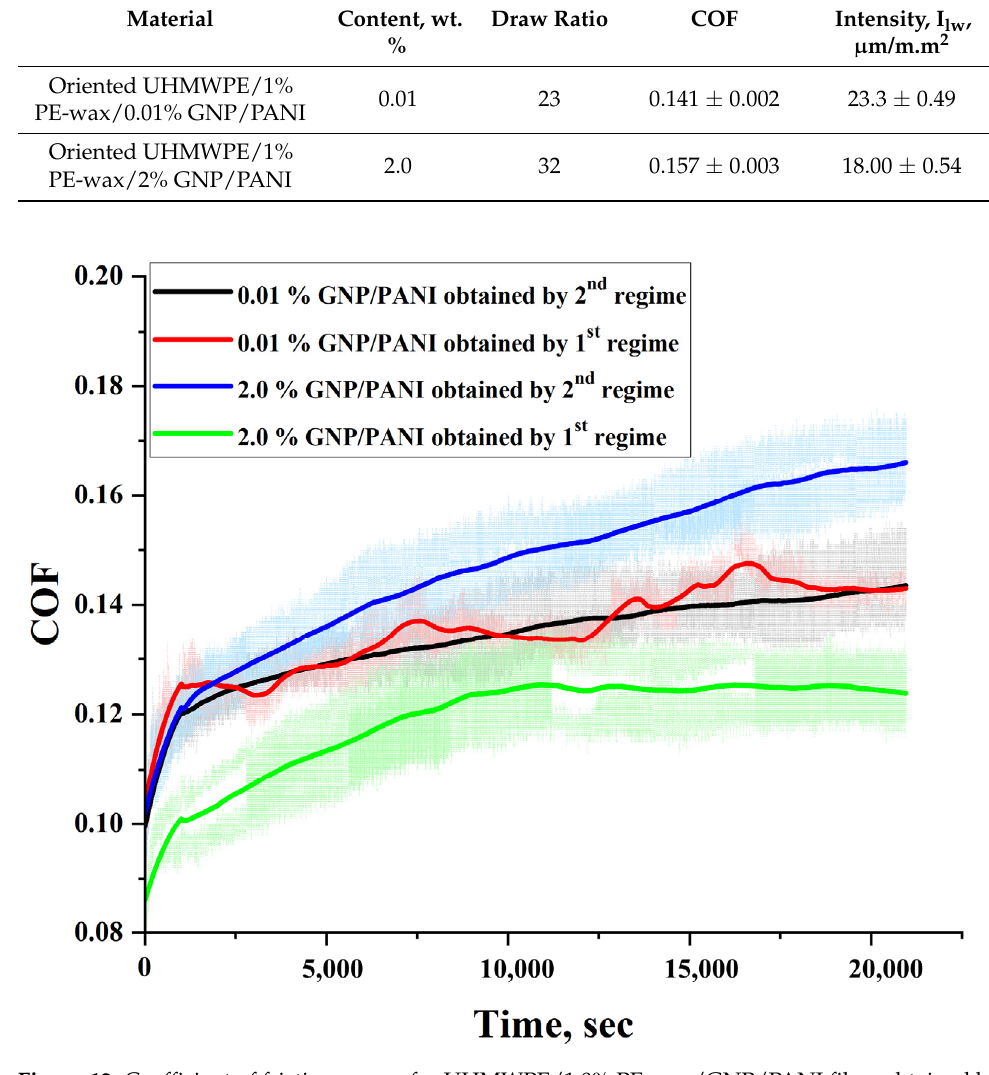
Figure 12. Coefficient of friction curves for UHMWPE/1.0% PE-wax/GNP/PANI films obtained by second thermal orientation regime in comparison with the films obtained by the first regime.